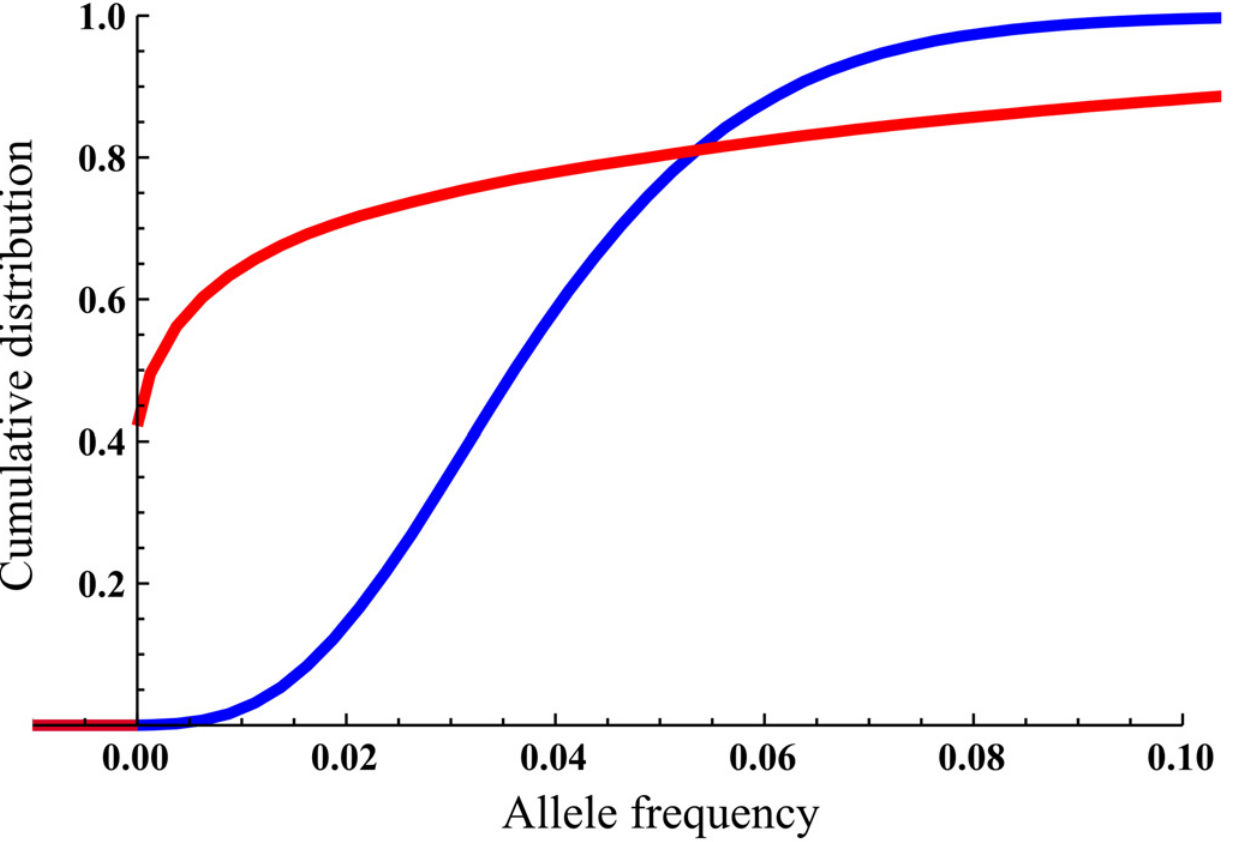
Fig 1. Cumulative density functions for the allele frequency at the equilibrium phase. M = 1 migrants in red, M = 30 migrants in blue; scenario parameters Q = 0.04, N 0 = 10, K = 400, r = 0.05, m = 0.05. The jump at allele frequency 0 for M = 1 is due to the low p presence for this